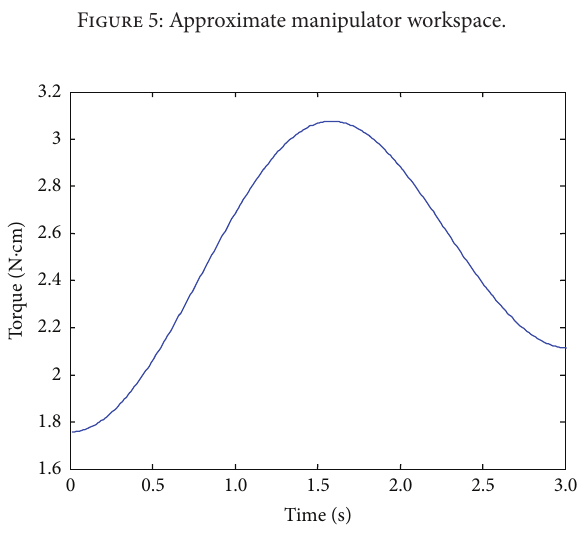
Figure 6: Torque profile of the single actuator. Table 1: EAP mechanical